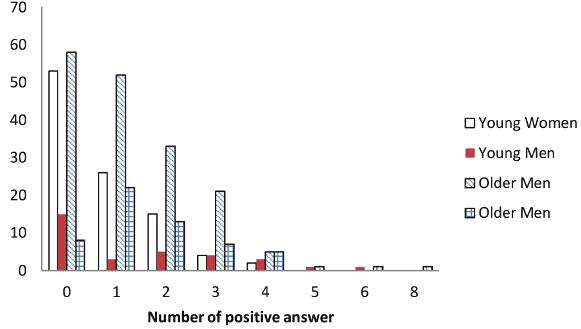
Figure 1: Comparison of number of positive answers to the IOF Test among the four